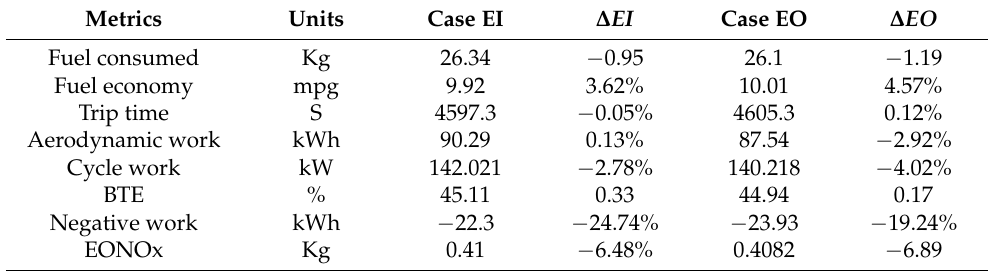
Table 6. Comparison of key metrics for the vehicle speed and coast management problem with engine idle and engine-off condition. The ∆ % is the comparison with the baseline simulation.